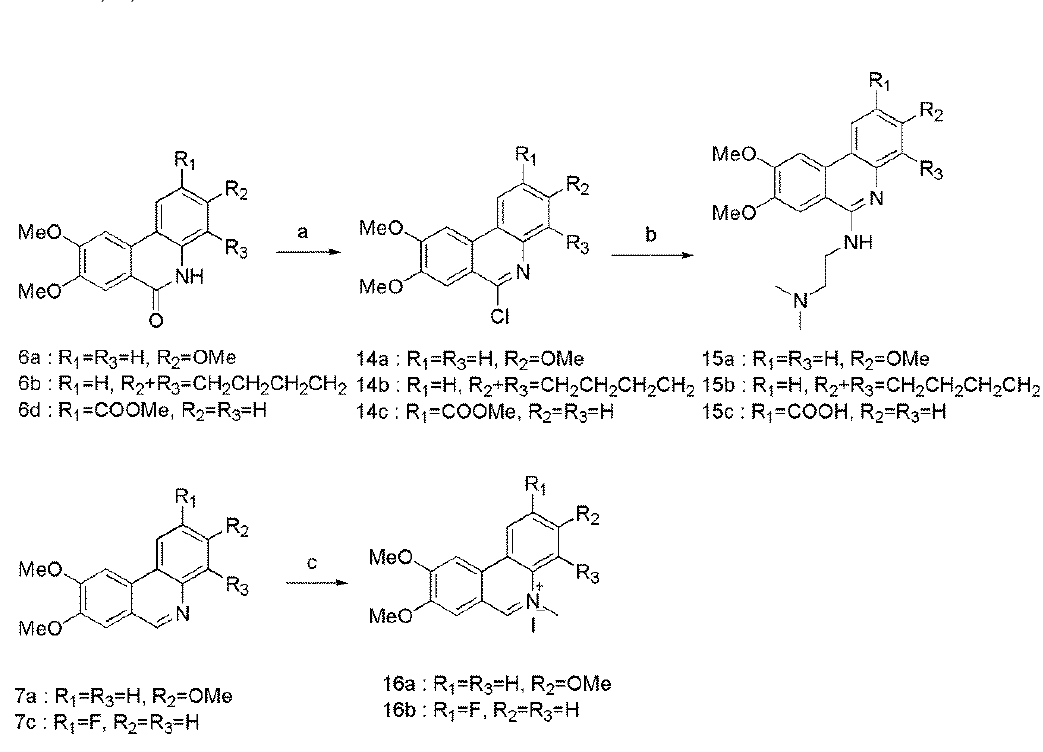
Table 1. Antitumor activity of some